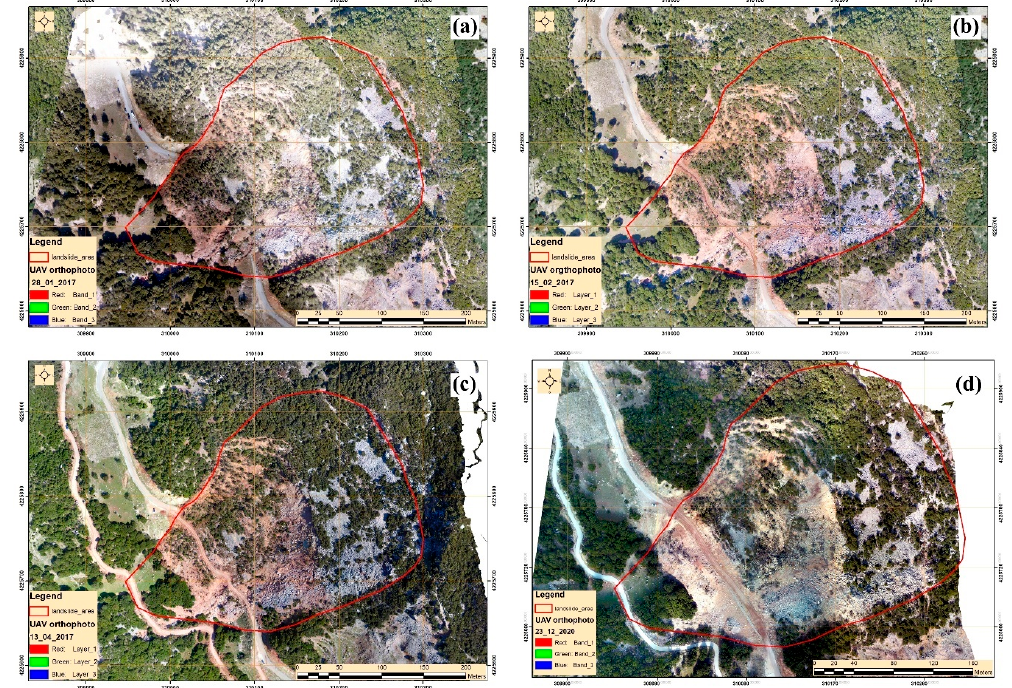
Figure 9. Continuous mapping of the landslide area. ( a ) UAV orthophoto on 28 January 2017. ( b ) UAV orthophoto on 15 February 2017. ( c ) UAV orthophoto on 13 April 2017. ( d ) UAV orthophoto on 23 December 2020. Red arrows show the direction of the movement.